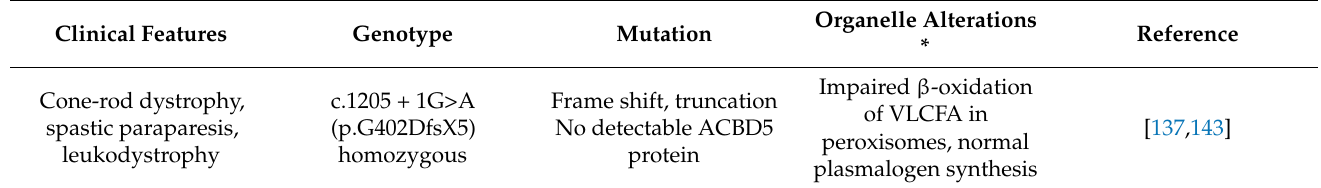
Table A4. Gene—ACBD5; Protein—Acyl-CoA binding domain containing protein 5; Function— patient-derived cells or plasma unless otherwise